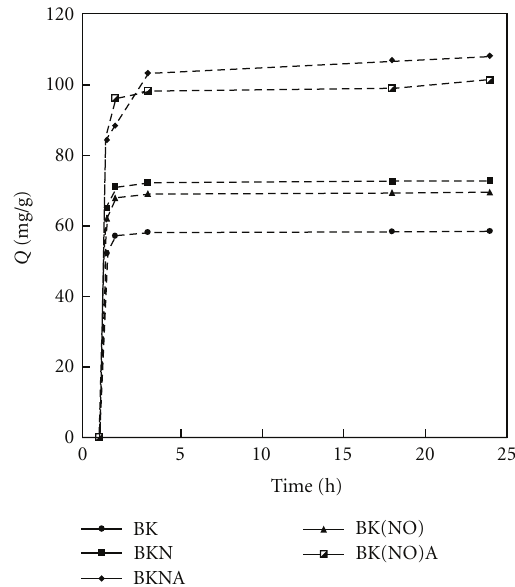
Figure 2: Fractional phenol removals as a function of time ( C initial = 500mg / L; 25 ◦